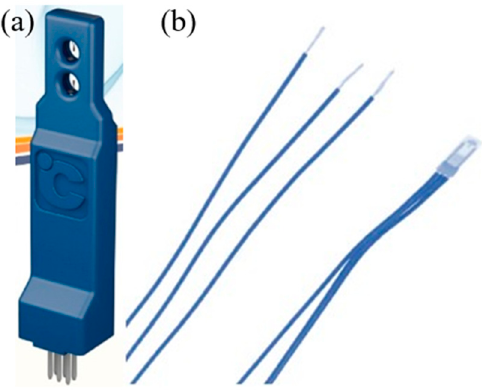
5 of 8 Figure 4. (a) Coating; (b) Exposure; (c) Lift ‐ off; ( d ) Optical micrograph of the flexible micro air ve ‐ locity sensor; ( e ) picture of the actual flexible micro air velocity sensor. 2.2. Comparisons between Commercial Air Velocity Sensors and the Home-built Micro Air Velocity Sensor The commercial sensors selected for the comparative study were the F660 and FS7.0.1L.195 commercial wireless air velocity sensors (Figure 5). A comparison between the performance of the two commercial air velocity sensors and the home ‐ built microsen ‐ sor is shown in Table 1. It was observed that the home ‐ built micro air velocity sensor had faster responses and a lower cost than the two commercial air velocity sensors. The FS7.0.1L.195 air velocity sensor requires an external circuit; hence, the circuit conforming to the FS7.0.1L.195 specification was developed and is shown in Figure 6a. The packaging was designed according to the mechanism inside the cold air ducts of HVAC systems and is shown in Figure 6b. Finally, the split conductor was connected, and the signals were